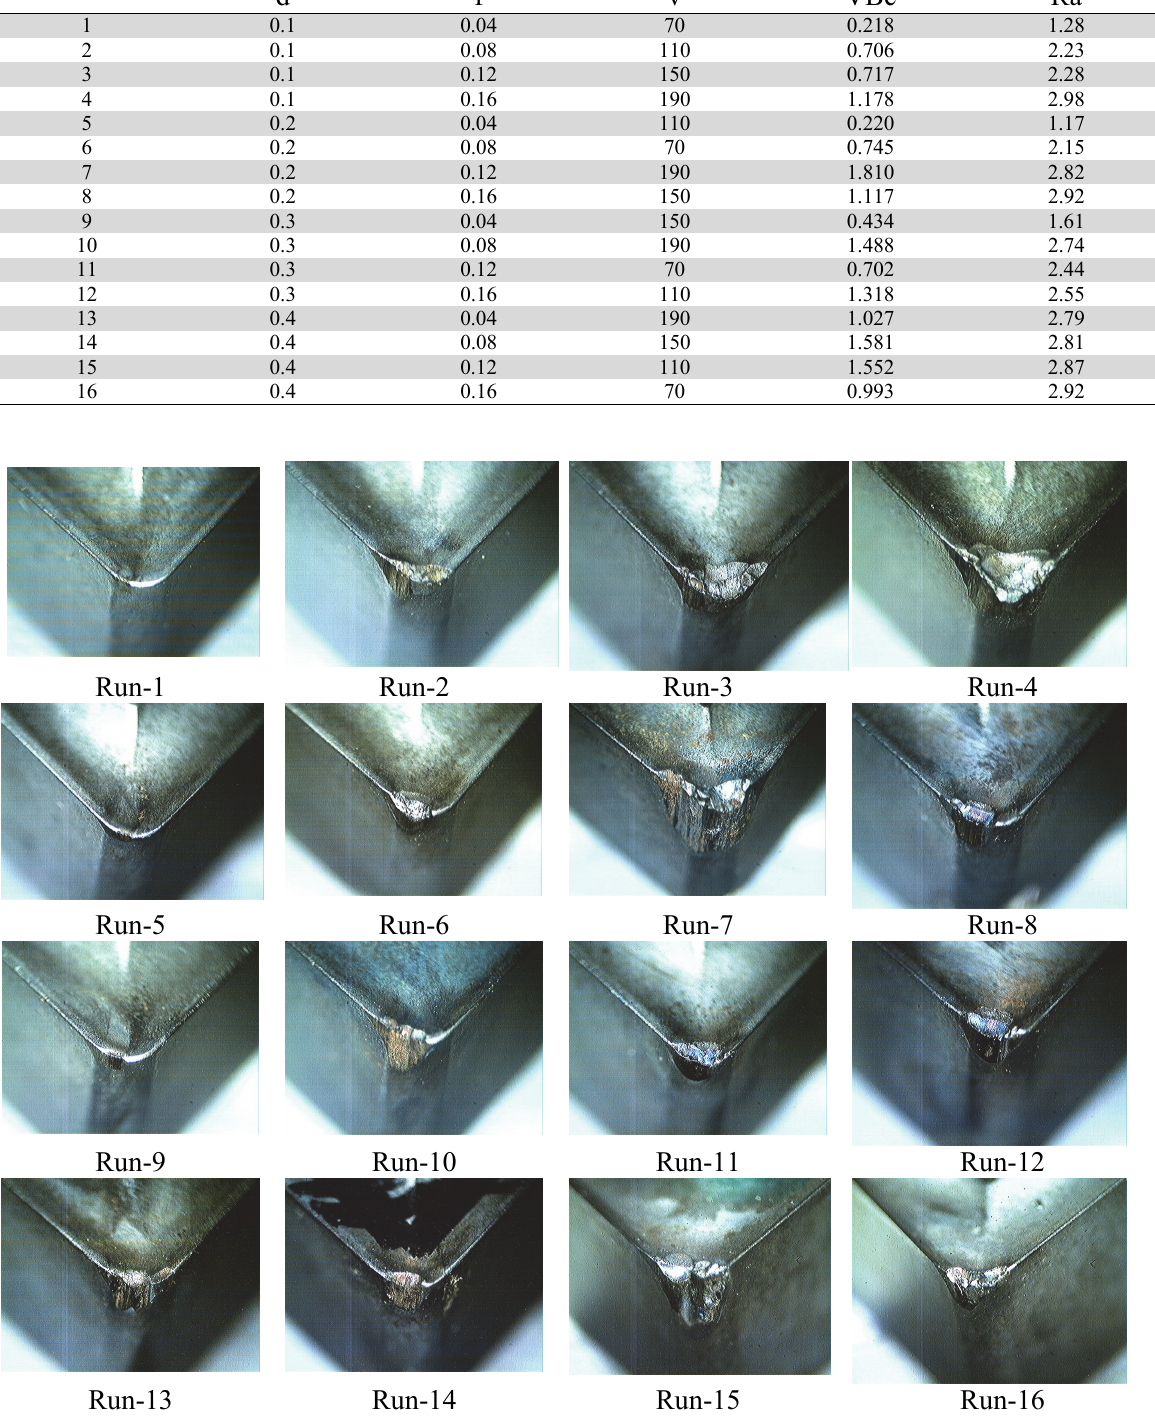
Fig. 2. Flank wear images at different